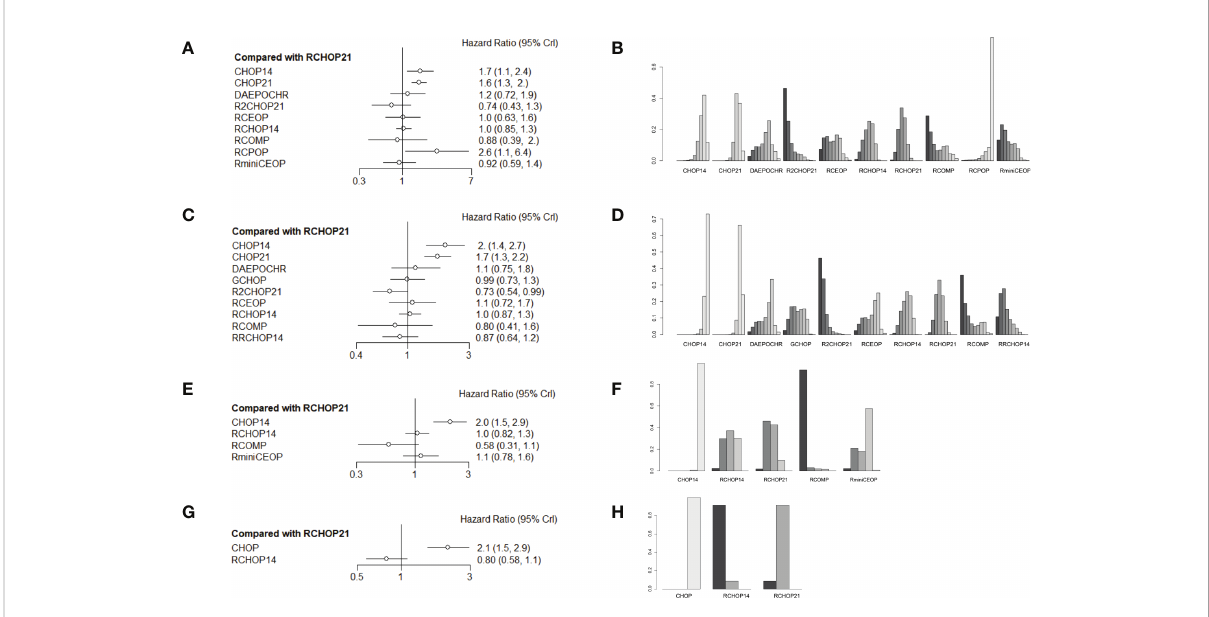
FIGURE 2 (A) Forest plot of overall survival; (B) Rank probability of overall survival; (C) Forest plot of progression-free survival; (D) Rank probability of progression-free survival; (E) Forest plot of event-free survival; (F) Rank probability of event-free survival; (G) Forest plot of disease-free survival; (H) Rank probability of disease-free